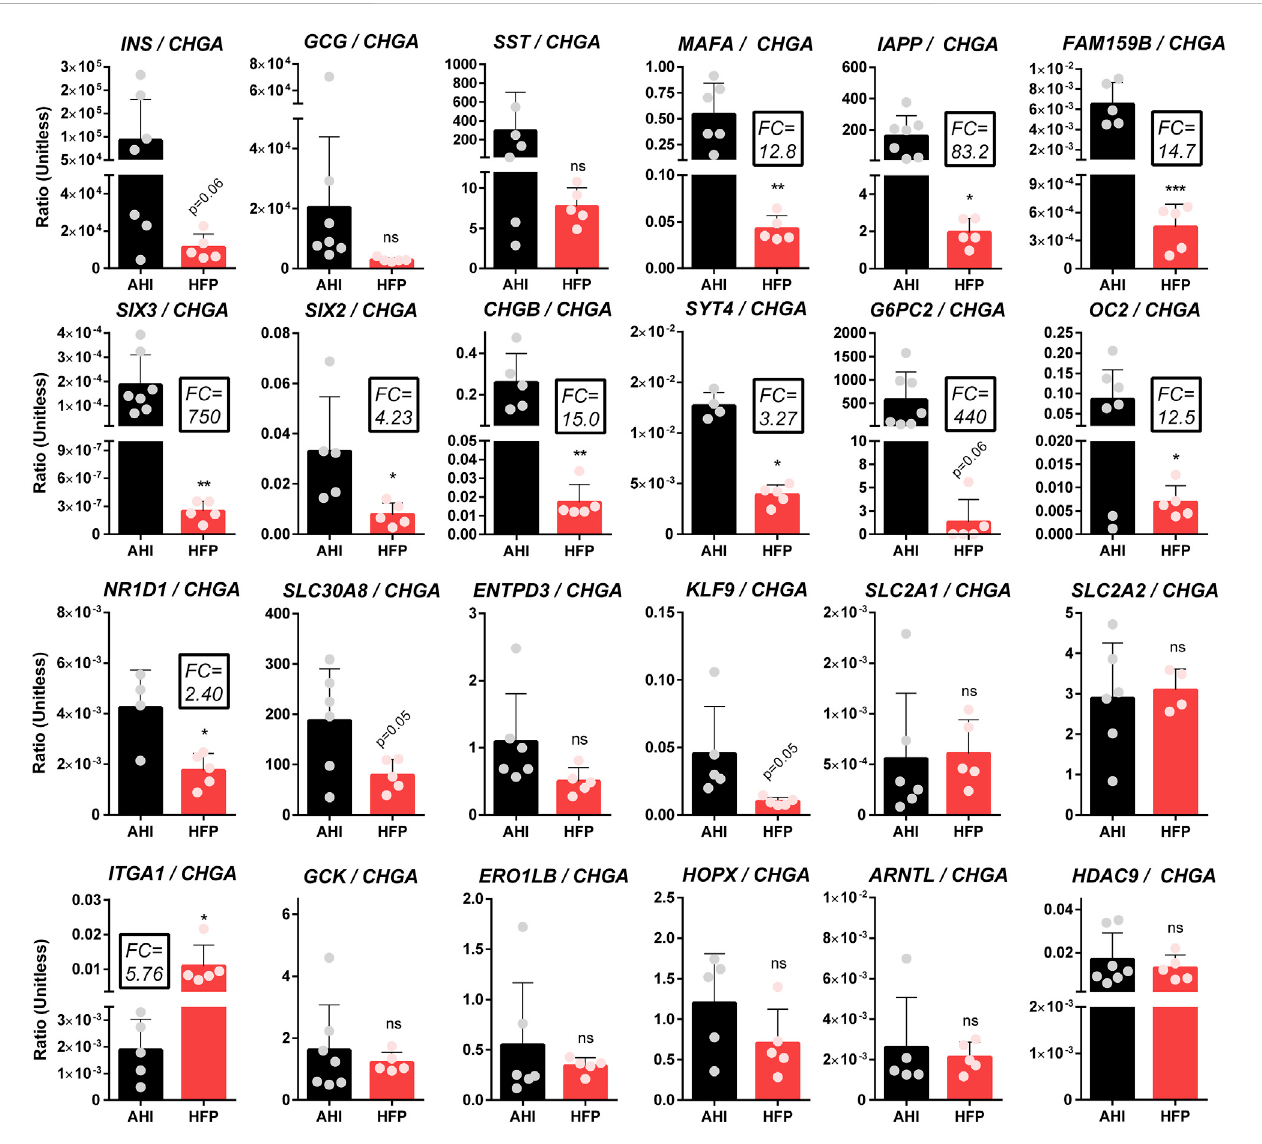
Geneexpressionofcandidatematurationmarkersinadulthumanisletsandfetalpancreas.QPCR-basedanalysisofgeneexpressionofseveralcandidate maturation markers in adult human islets ( “ AHI ” ) and human fetal pancreas ( “ HFP ” ). All genes were normalized to β actin within the same sample, then normalized to undifferentiated H1 cells and presented as a ratio of gene expression over CHGA to normalize for differences in endocrine mass between the various samples. Fold changes (FC) listed highlight major differences in gene expression between AHI and HFP. Statistical indicators directly above each bar are compared to AHI (ns = not signi fi cant, * p < 0.05, ** p < 0.01, *** p <